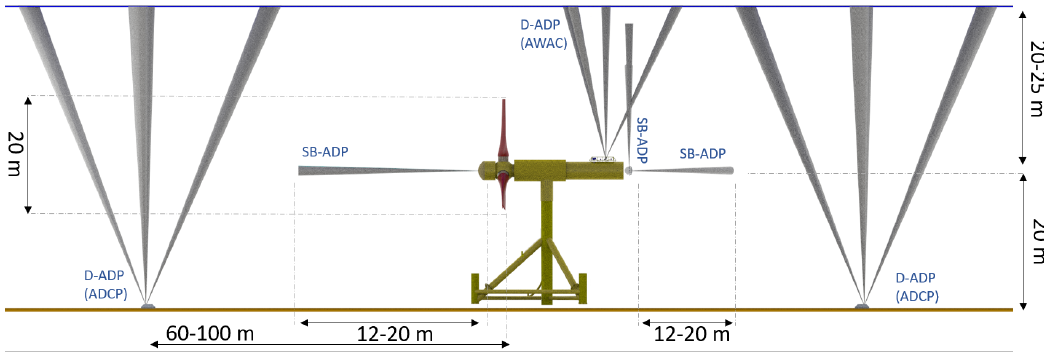
Figure 3. Instrument layout on the DeepGen-IV tidal turbine. Acoustic beams are represented in grey.